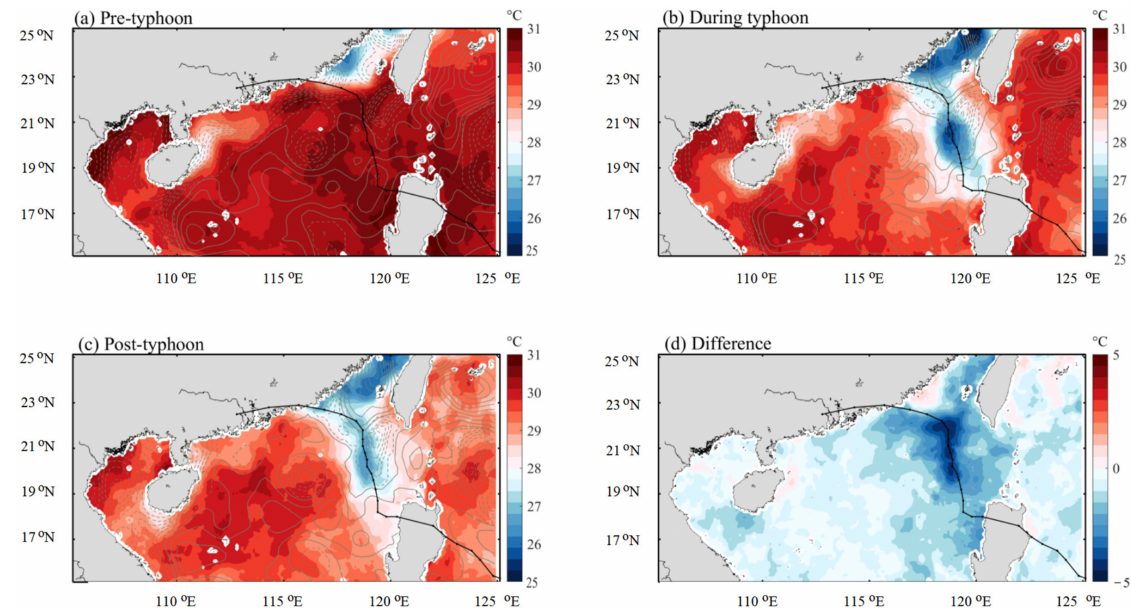
Figure 6. Spatial distribution of sea surface temperature during pre-typhoon ( a ) 1–5 July, during typhoon ( b ) 6–9 July, and post-typhoon ( c ) 10–12 July, and difference ( d ) 10–12 July minus 1–5 July. The gray line represents the sea level anomaly. The black line denotes typhoon